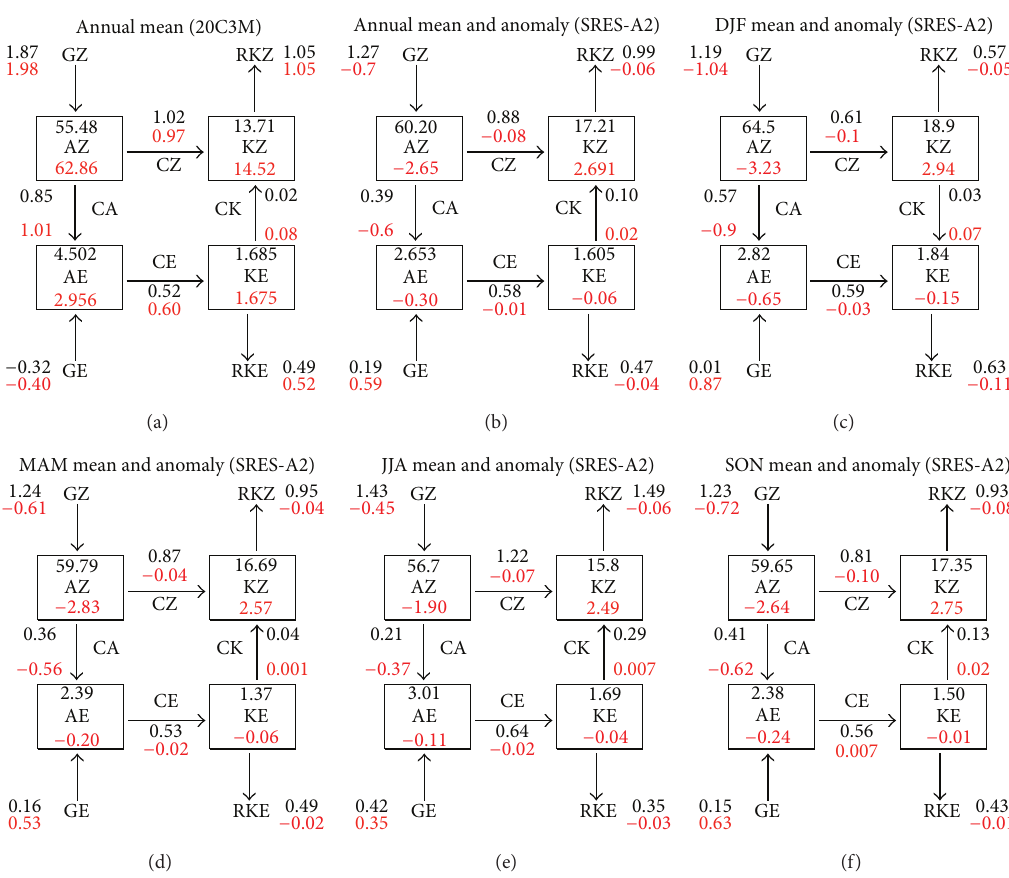
Figure 12: (a) Representation of the annual mean of SDLEC for an ensemble of reanalyses (black) and CGCMs (red) relative to 20C3M, (b) annual mean SDLEC for the ensemble of CGCMs (black) and anomaly (red) for the period of 2079–2099 (c). Panels (c), (d), (e), and (f) are representative SDLEC, respectively, for DJF, MAM, JJA, and SON seasons for the period of 2079–2099. Standard units are 10 5 Jm 2 and Wm −2 , respectively, for energy and conversion